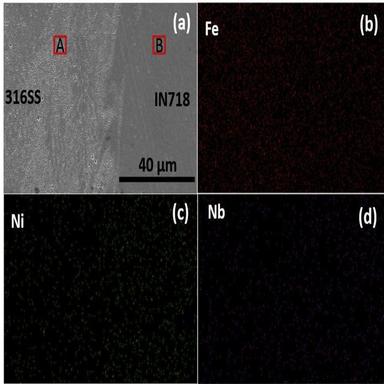
EDS elemental concentration map of 316SS/IN718 interface.